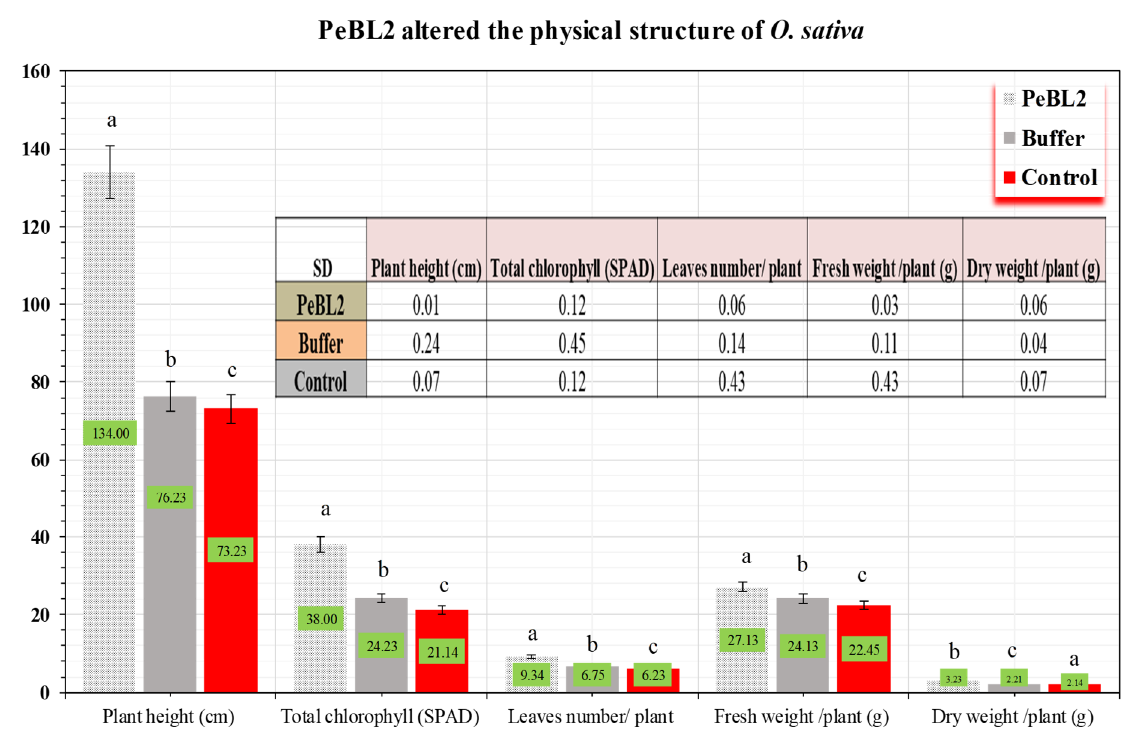
Figure 6. Effect of PeBL2 on growth of PeBL2-treated and control seedlings of O. sativa . Data shown in mean (± SD) of PeBL2, buffer, and control seedlings ( n = 10). (a–c) small letters on each bar are significant differences among treatments and control. The data were compared using LSD, one-way ANOVA, and Levene’s test in SPSS 18.0. (p = 0.05).